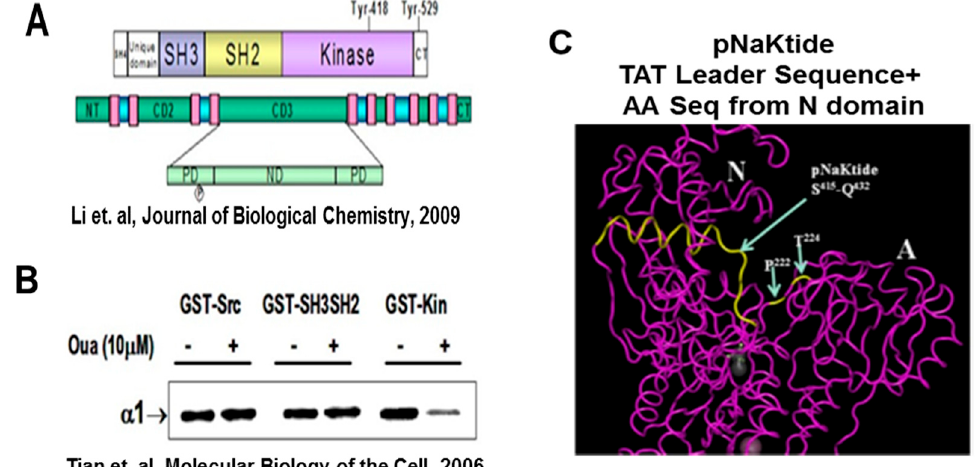
Figure 3 . Depiction of alignment of the Na/K-ATPase alpha1 subunit with the Src Kinase domain. Further exploration defined a 20-aminoacid sequence in the N domain (part of CD3 domain) of alpha1, which binds Src’s kinase domain (NaKtide). ( A ) Schematic illustration of the structure of Src representing the SH3-SH2 domain, tyrosine kinase, and different GST-fusion proteins [27]. ( B ) Western blot analysis demonstrating the ouabain-induced release of kinase domain from the Na/K-ATPase, blotted against anti- α -1 antibody [28]. ( C ) Schematic structural representation of a portion of the TAT protein to form a 33 AA cell permeant peptide, pNaKtide. Source: Tian et al. (2006) and Li et al. (2009) [27,28].